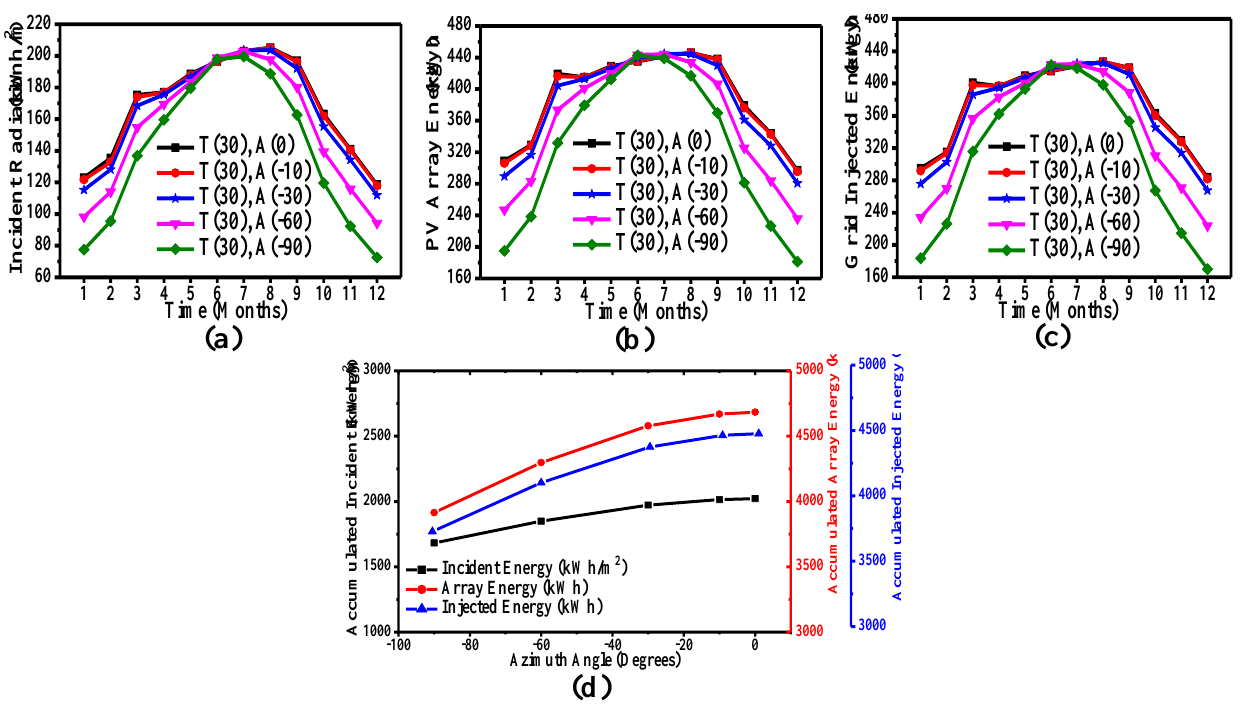
Figure 5: [T(30), A(-x)] configuration: (a) incident radiation received by the module surface, (b) generated energy by the array, (c) energy injected to the grid, and (d) accumulated incident, generated, and injected energies over one